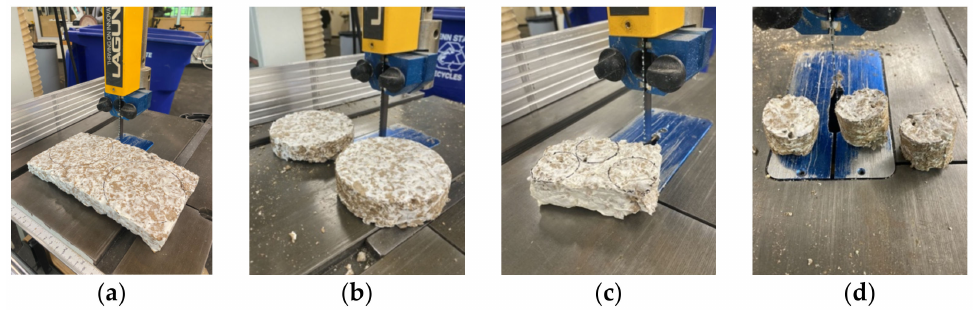
Figure 3. Sample Shaping of Fine Cardboard Material: ( a ) Large Formwork Dried Fine Cardboard Sample; ( b ) FCL Samples (100 mm diameter, 38 mm thickness); ( c ) Small Formwork Dried Fine Cardboard Sample; ( d ) FCH Samples (29 mm diameter, 38 mm